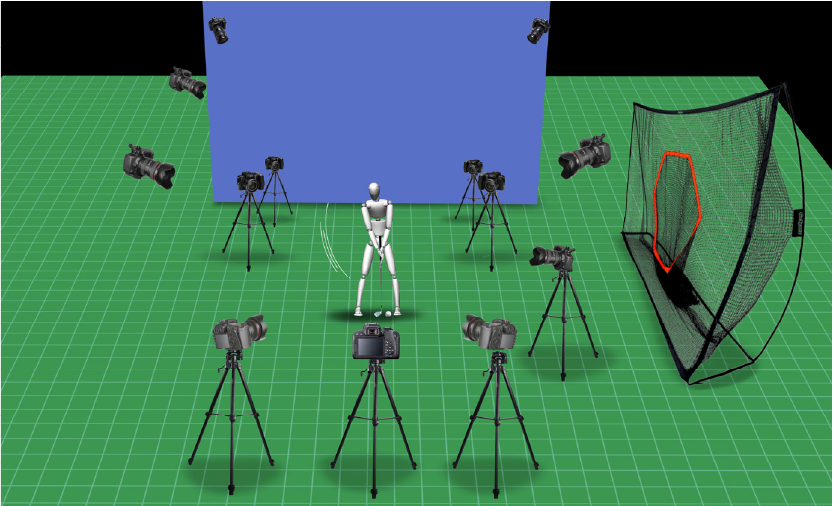
Figure 1. Experimental set-up. EMG and motion data were synchronized by Motive. Caddie SC300GPS was used to measure swing performance.